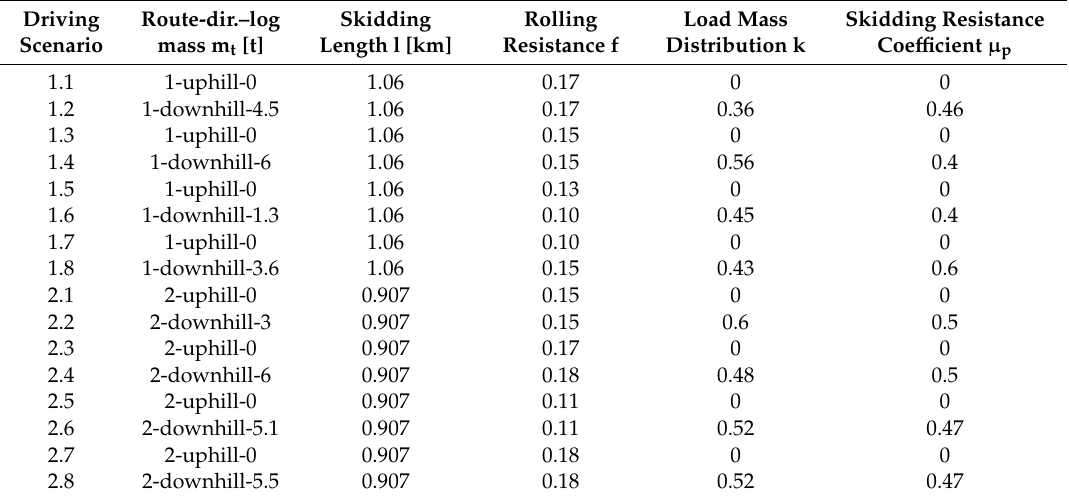
Table 5. Driving Table 5. Driving scenarios.